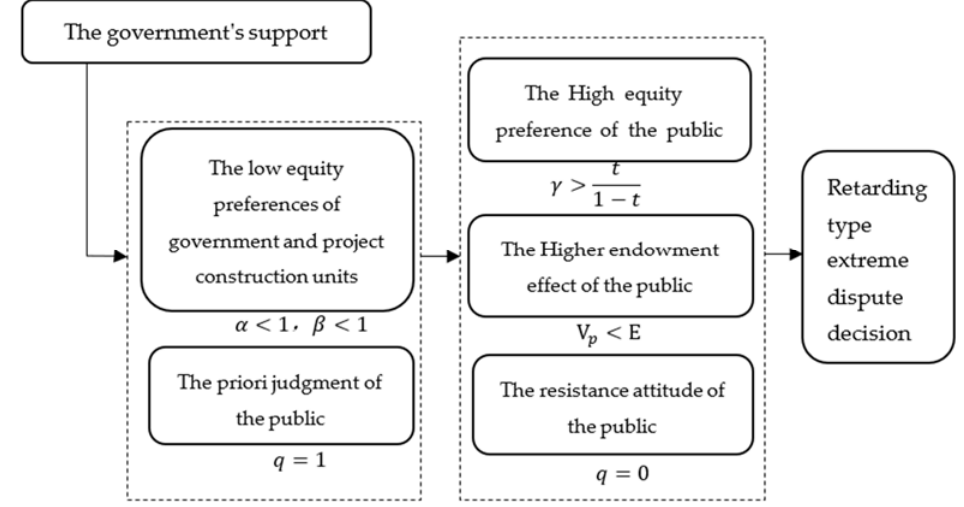
Figure 5. The formation path diagram of retarding-type extreme dispute decision.